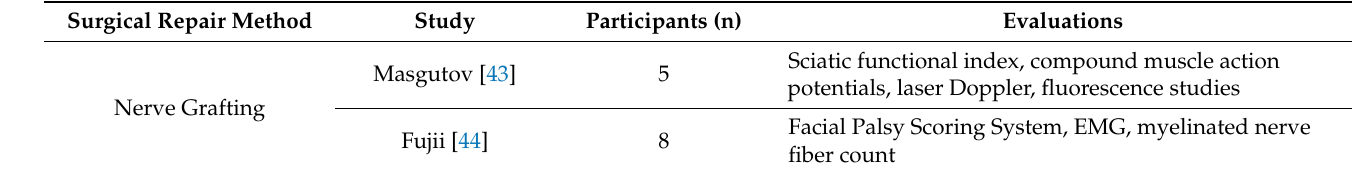
Table 2. Participant number and outcome evaluations from studies of animal nerve grafting surgery with use of ADSCs. Only studies that evaluated at least one functional outcome are listed in the table. Surgical Repair